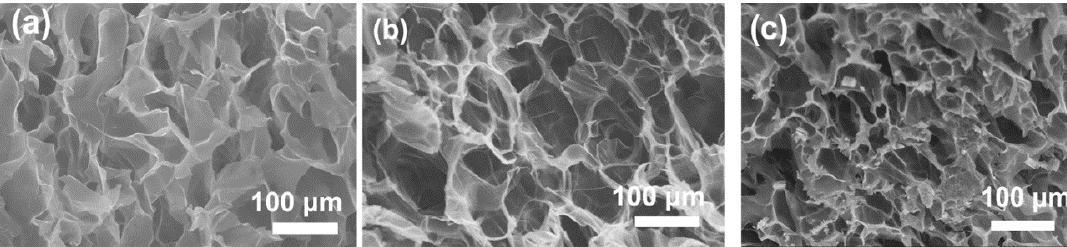
Figure 6. SEM images of SA, OP0-PN3, and OP3-PN3 gels. Network morphology of gels for observation was prepared by freeze-drying. ( a ) SA gels; ( b ) OP0-PN3 gels; ( c ) OP3-PN3 gels.